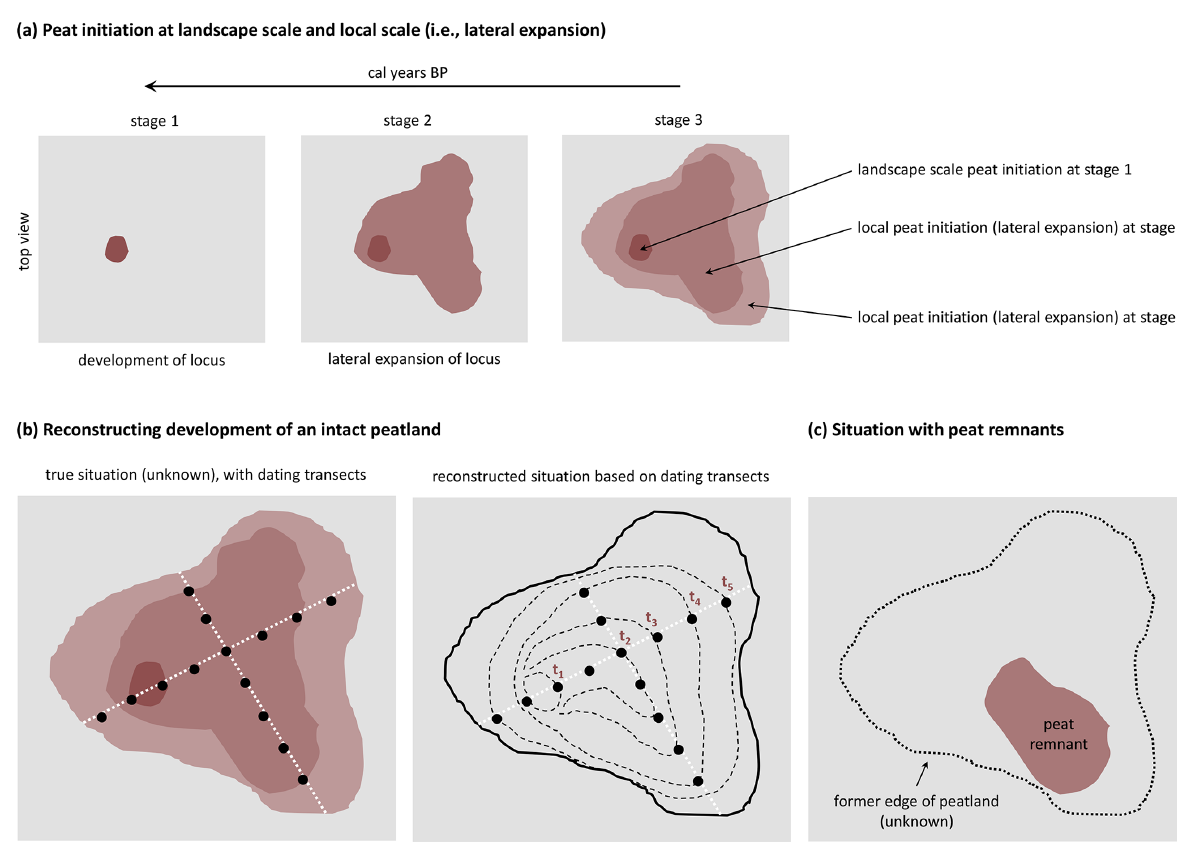
Figure 1. Conceptual illustration of peat initiation and lateral expansion of peatlands. (a) Schematic top view of a landscape (peat is indicated in brown), showing the meaning of peat initiation at the landscape and local scales (redrawn from Quik et al., 2022). (b) Approach to reconstruct peat initiation and the pattern of lateral expansion using dating transects and isochrones for an intact peatland. (c) Situation when only remnants of the former peat landscape